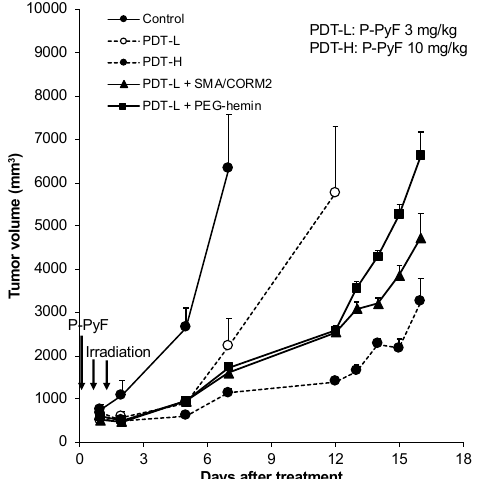
Figure 4. Enhancement of therapeutic effect of PDT using P-PyF in combination with CO generators on B16 tumors. When the tumor diameters reached about 10 mm, P-PyF (3 and 9 mg/kg) was injected i.v. PEG-hemin and SMA/CORM2 were administered in the same way as the protocol in Figure 3. After 24 and 48 h of P-PyF injection, the tumors were irradiated by a xenon light (120 mW/cm 2 , 5 min, 36 J/cm 2 ). Data are means ± SD; n = 4–8. See text for details.